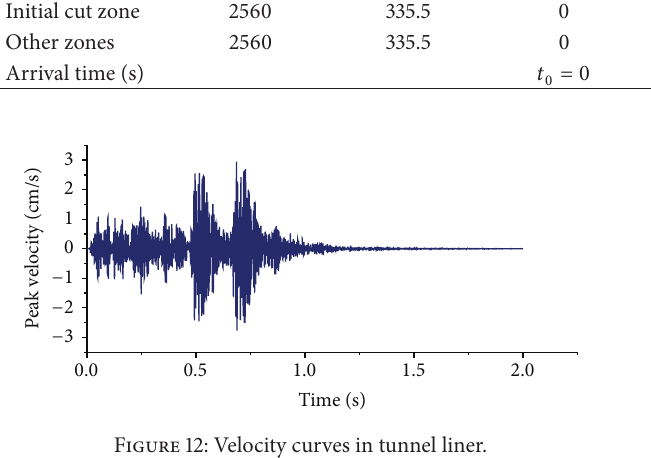
Figure 12: Velocity curves in tunnel liner.